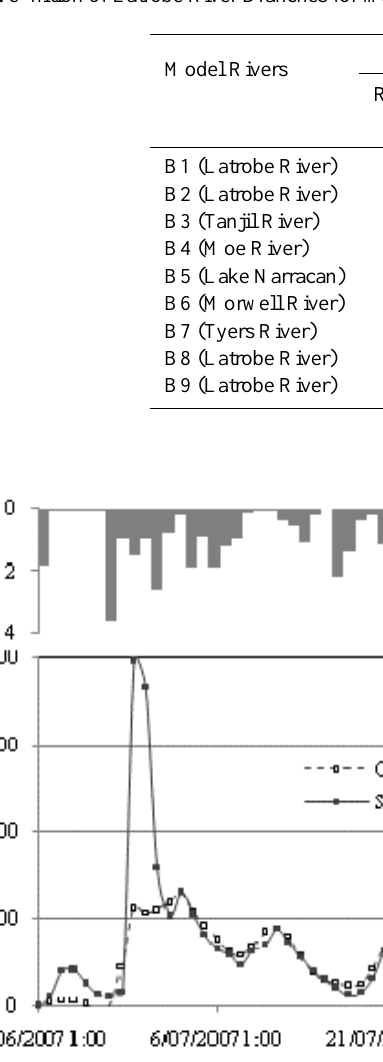
Table 6. efinition of Latrobe River Branches for model simulation.